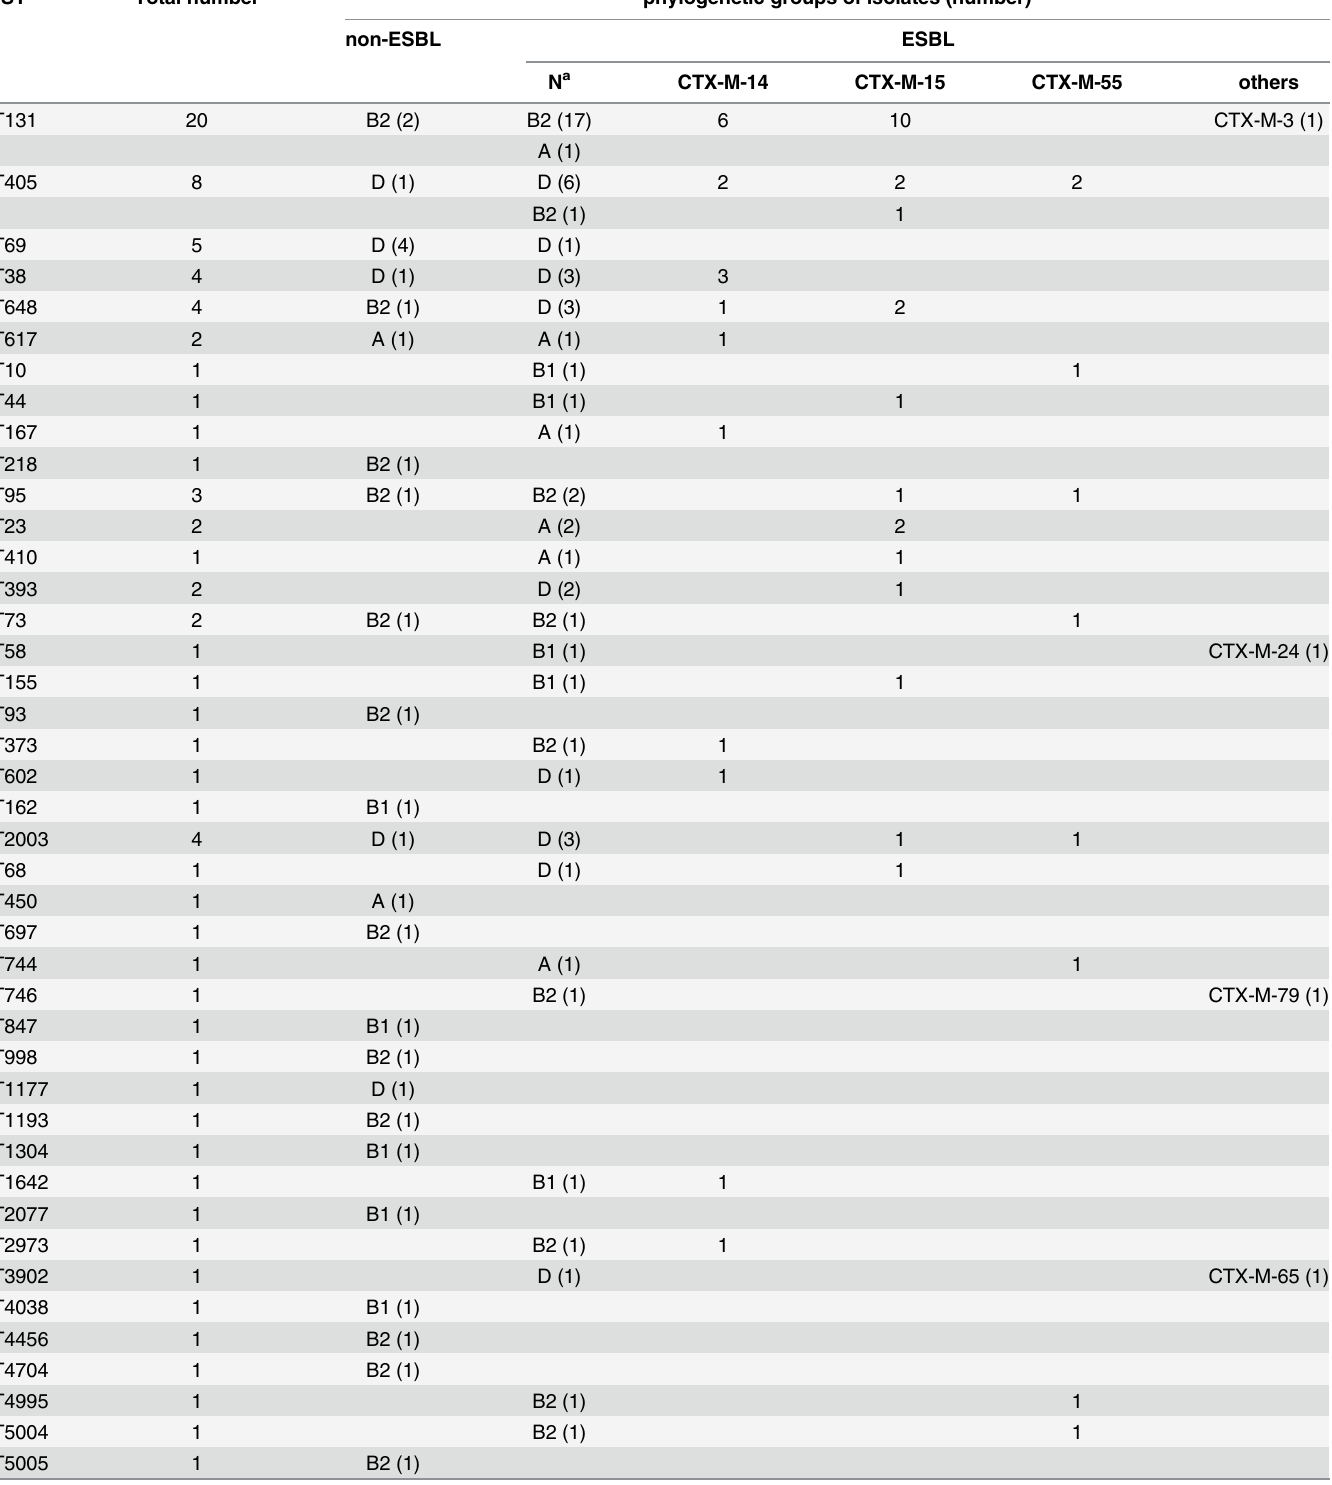
Table 4. Genotypes in MLST of Ninety E . coli isolates from Bloodstream